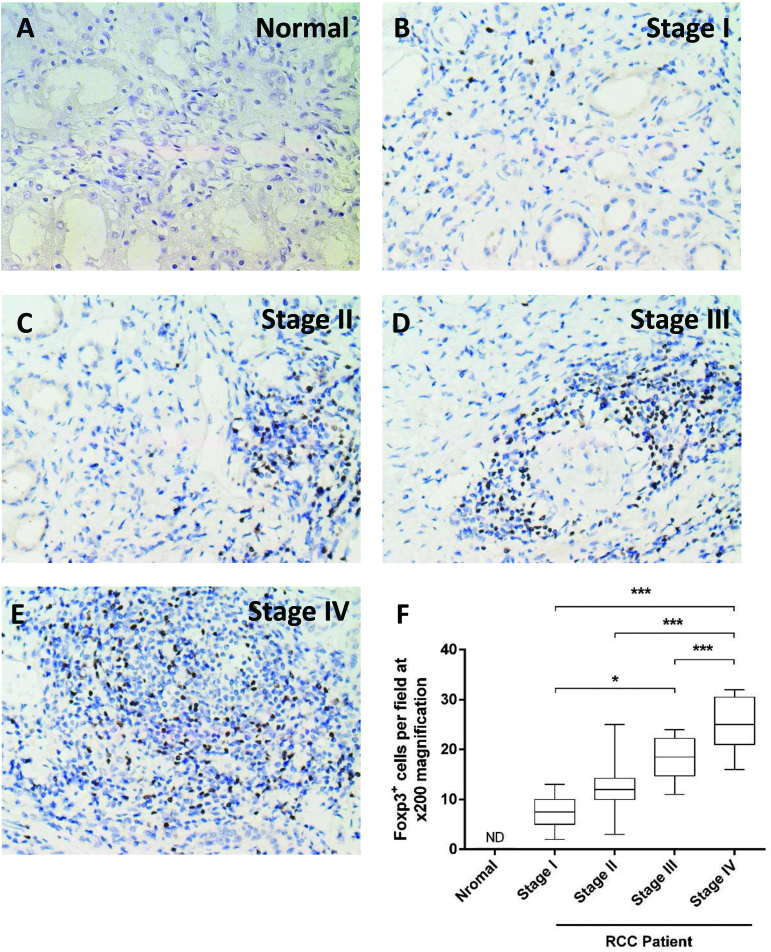
Immunostaining Foxp3 in normal kidneys and different tumor stages. (A) Expression of Foxp3 was not observed in the normal kidneys (A-E) The number of Foxp3+ cells in the tumor tissue increased between stages I and IV and the number of Foxp3+ cells was significantly higher in stage IV than in stages I-III. In addition, (F) Foxp3+ was also increased significantly in stage III compared with stage I. Data are expressed as the mean ± standard error of the mean. RCC, renal cell carcinoma. *P<0.05; ***P<0.001.